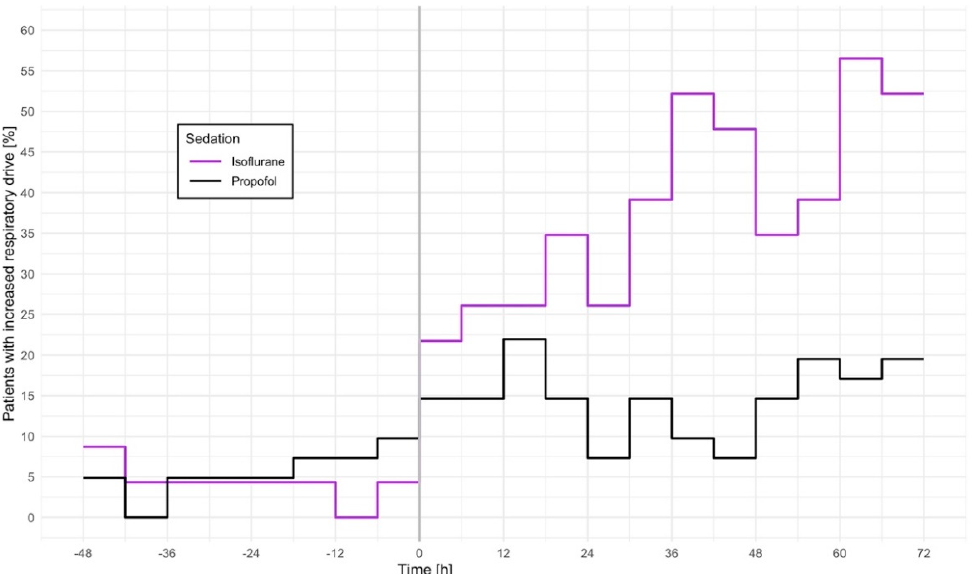
Figure 2. Percentage of patients with increased respiratory drive. Sedation was stopped at time point 0. Data are presented in 6-hour intervals as percentage of patients within each sedation group. The risk for increased respiratory drive after sedation stop was three times higher in patients sedated with isoflurane than in those receiving propofol: adjusted risk ratio [95%CI]: 2.9 [1.3, 6.5], p = 0.010. Increased respiratory drive was defined as arterial carbon dioxide partial pressure (P a CO 2 ) < 35 mmHg and base excess > -2 mmol/L.